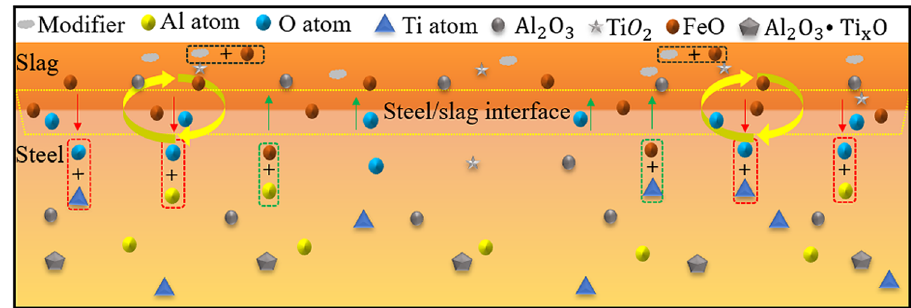
Figure 9: Schematic diagram of reaction mechanism of modi fi er - slag -